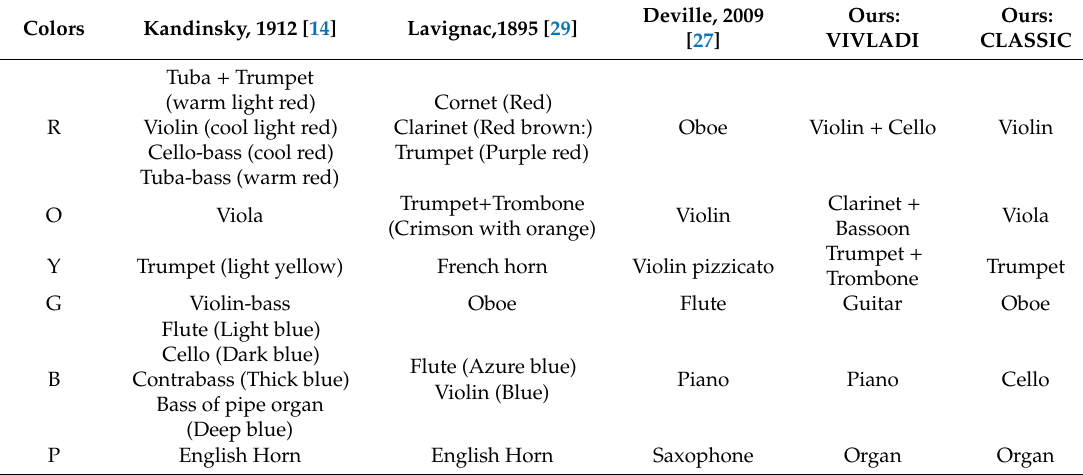
Table 1. Existing SCCs with instruments and ours.